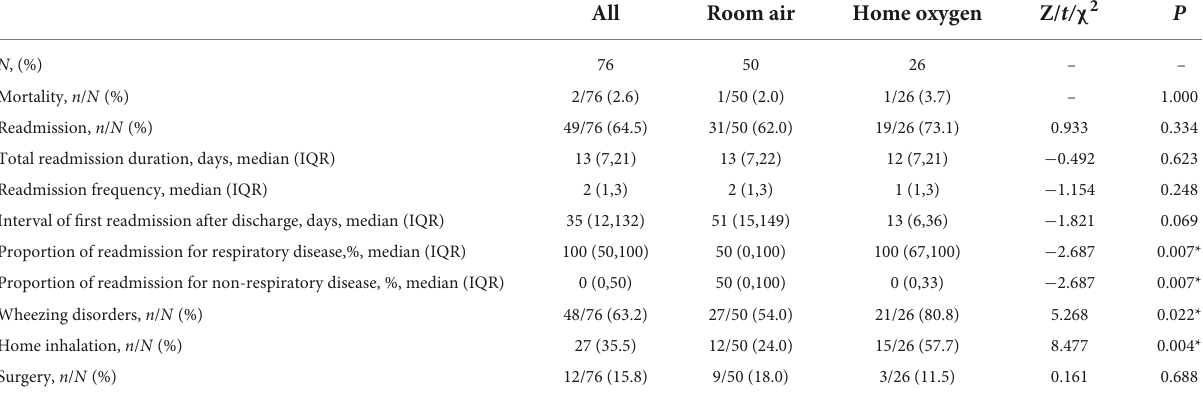
All Room air Home oxygen Z/ t/ χ